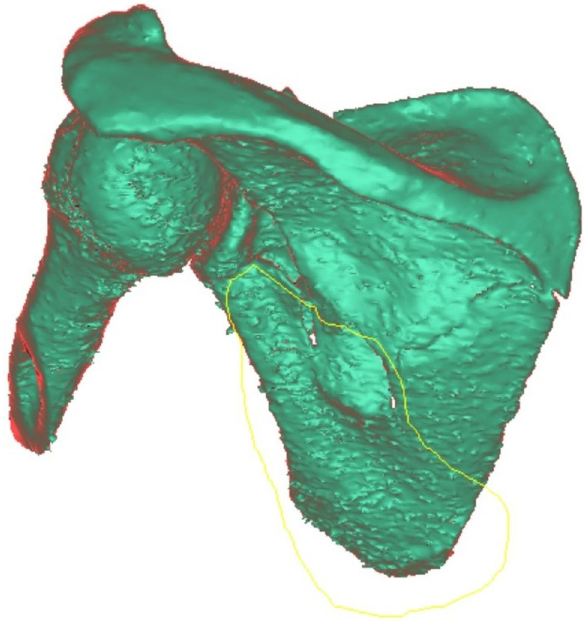
Figure 2: Manual rough delineation of the fracture fragments.